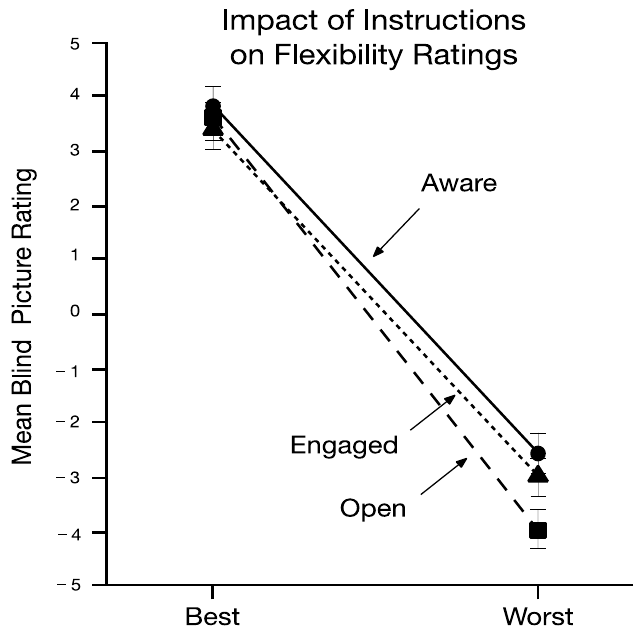
Figure 1. Mean open, aware, and engaged ratings for best and worst poses.